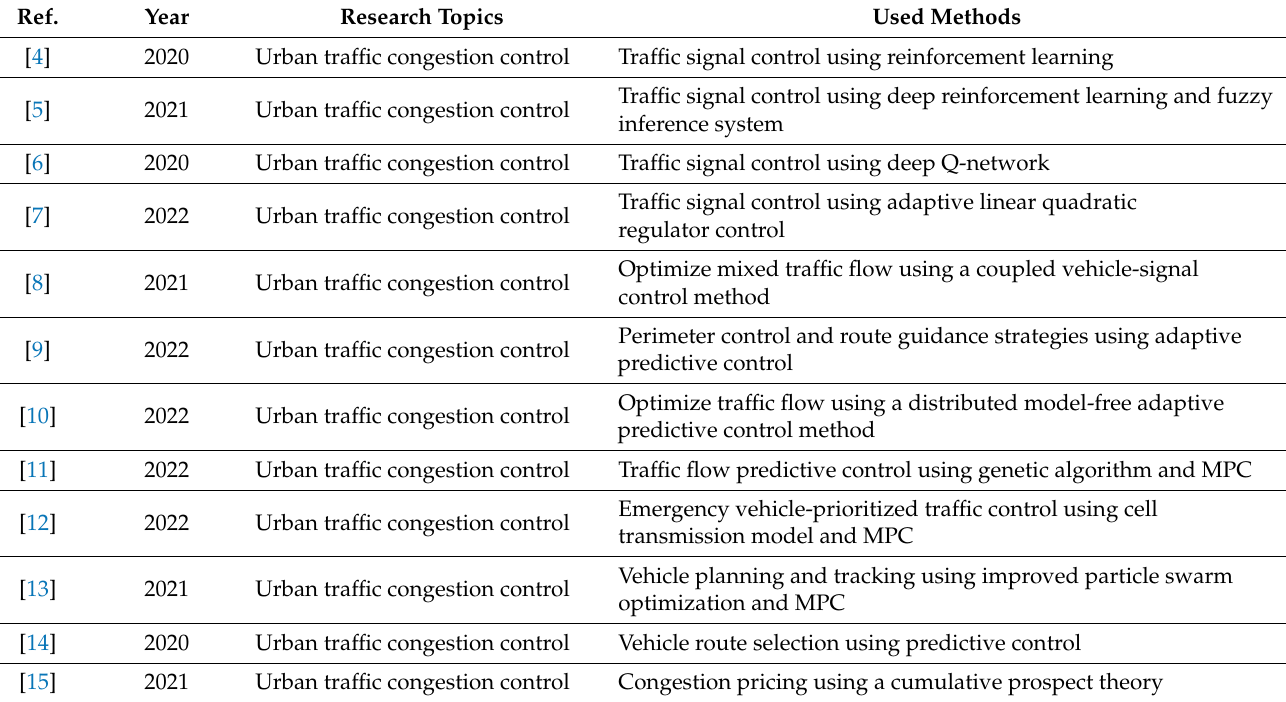
Table 1. The summary of related work.